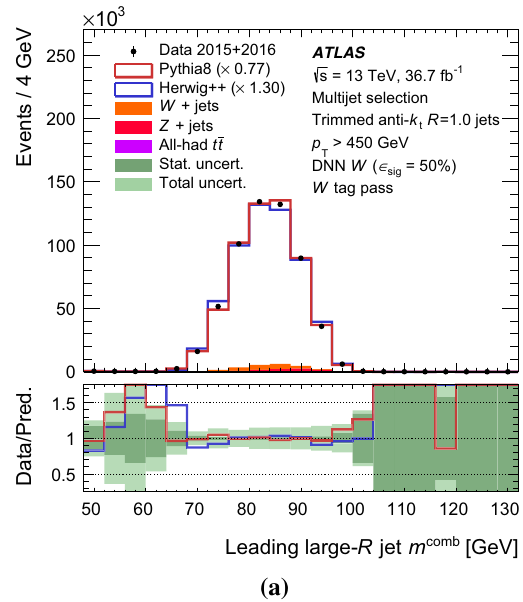
the specific sample to which it applies. Systematic uncertainties are indicated as a band in the lower panel and include all experimental uncertainties related to the selection of events, as well as the recon- struction and calibration of the large- R